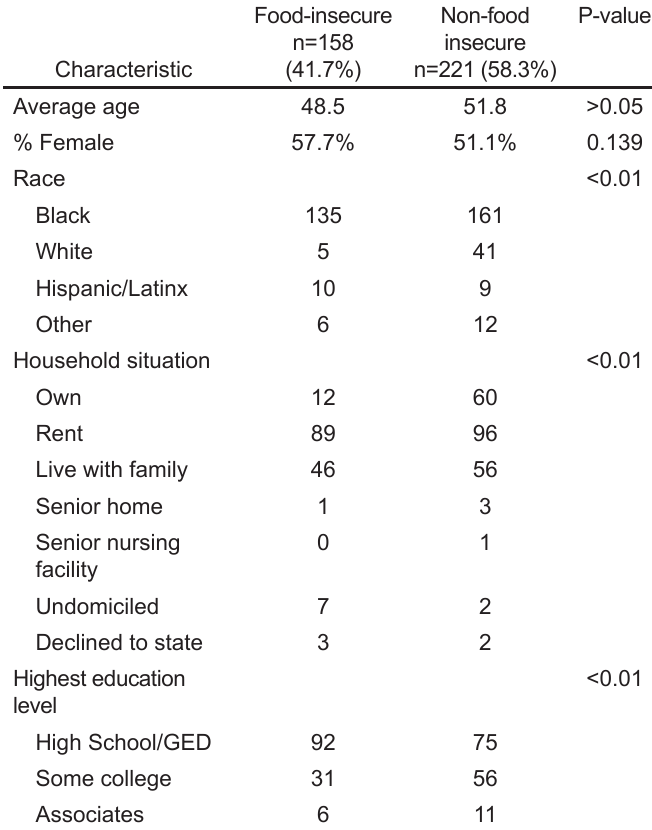
Table 1. Patient characteristics in intra-pandemic